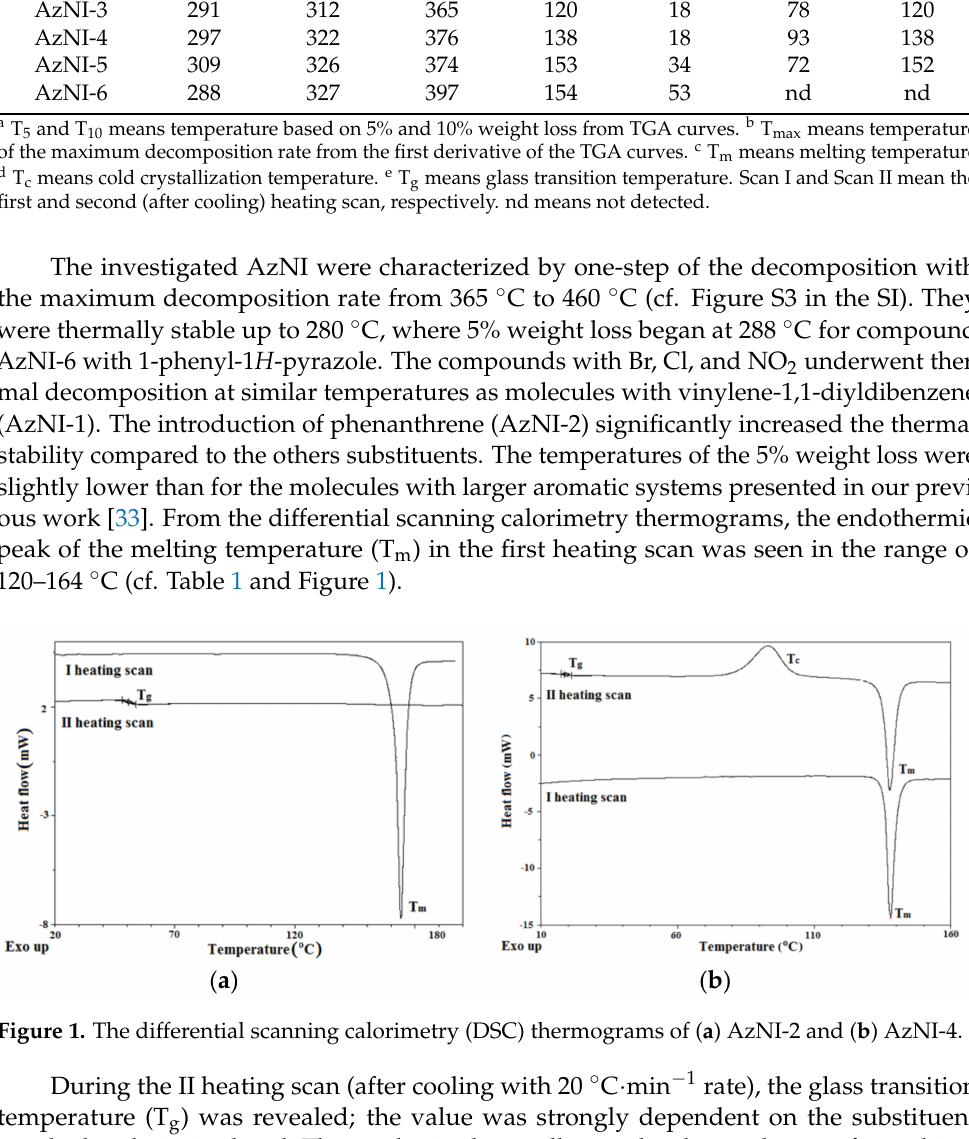
b T max means temperature